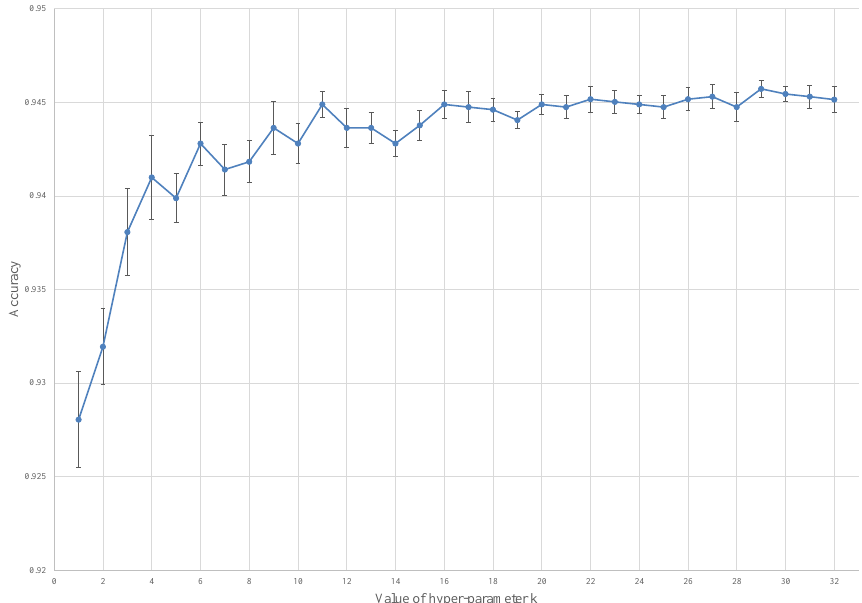
Figure 6. Comparison of different k in k -NN